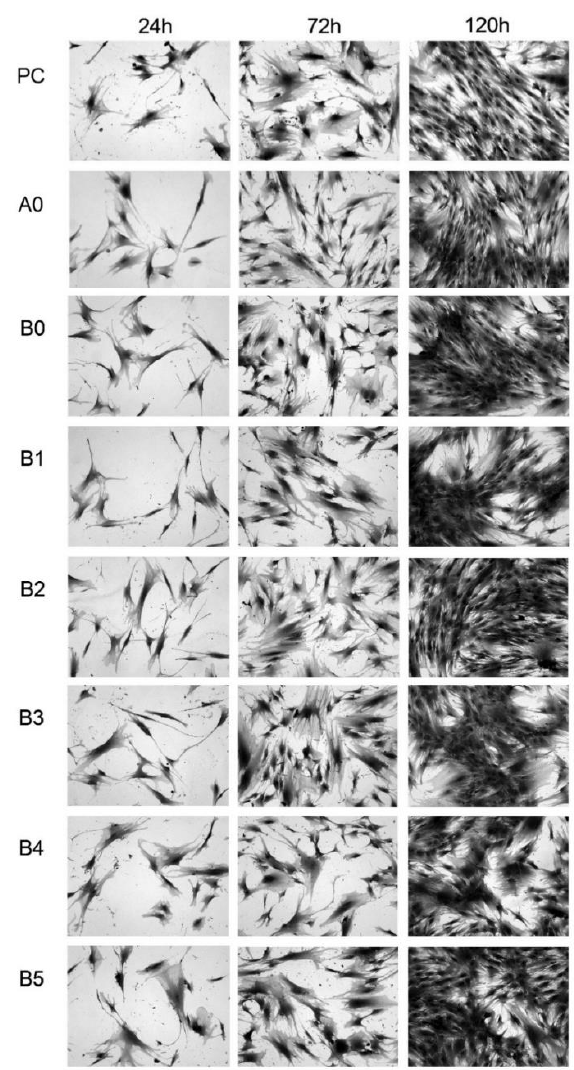
Figure 9. Morphology of the Human Periodontal Ligament Fibroblasts (HPdLF) cells cultured in different conditioned media for different times: 24, 72, and 120 h: positive control (PC), microcrystalline Ti (A0), ultrafine-grained Ti23Zr25Nb alloy (B0), ultrafine-grained Ti23Zr25Nb alloy electrochemically modified (B1), and Ti23Zr25Nb—9 wt.% 45S5 Bioglass (B2), Ti23Zr25Nb—9 wt.%